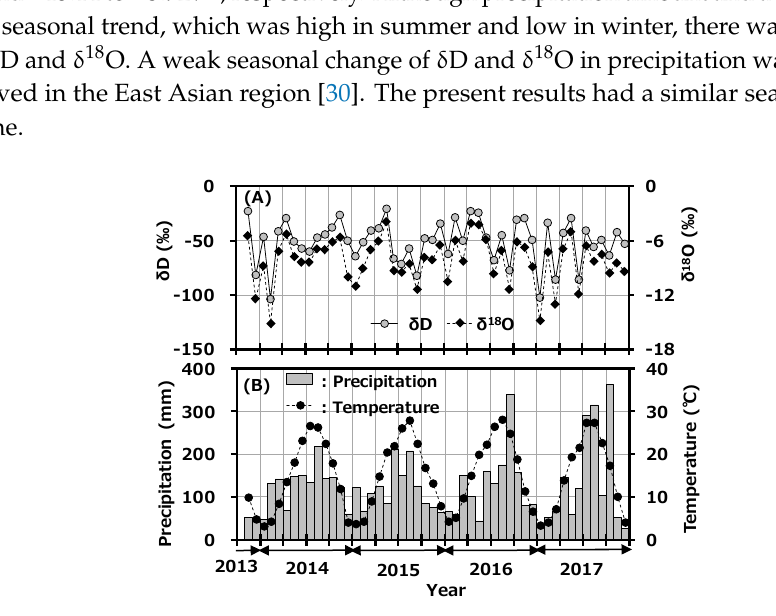
Figure 3. Variations of δ D and δ 18 O in monthly precipitation collected at Toki, Japan with monthly precipitation amount ( A ) and the reported monthly average temperature at the Tajimi AMeDas site ( B ). In general, δ D and δ 18 O in global precipitation are well-related by the following